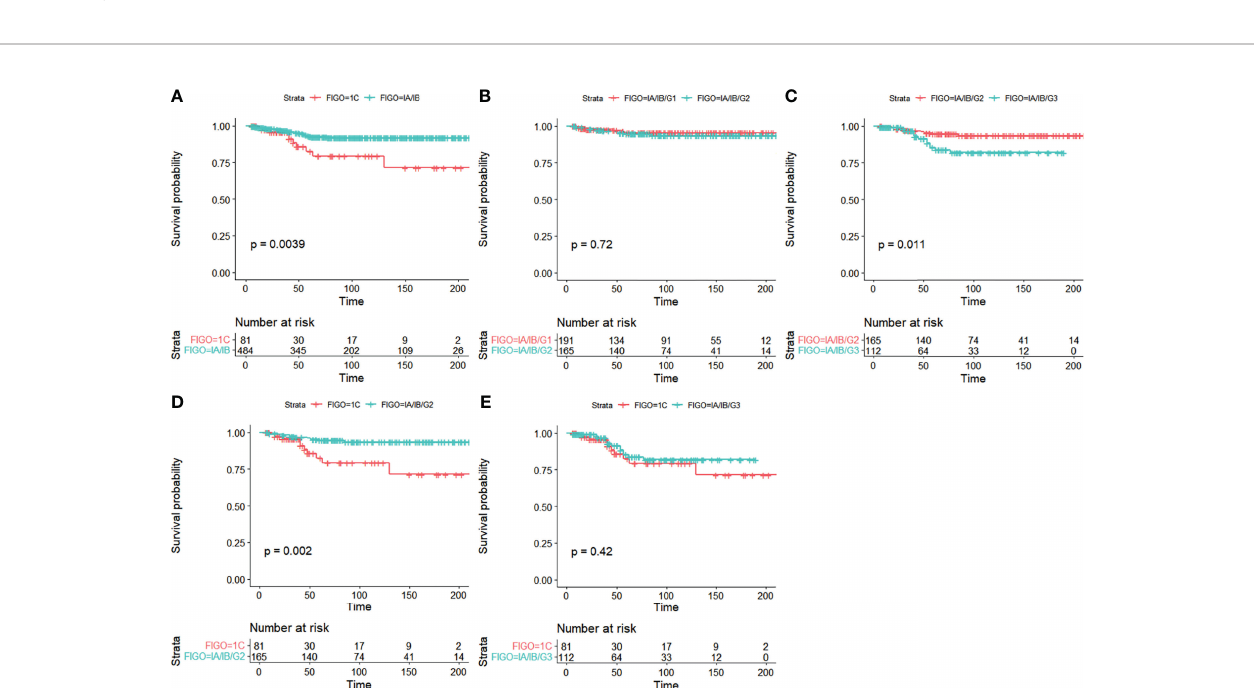
FIGURE 2 | Kaplan – Meier curves for CSS in stage I EOC. (A) Stage IA/IB vs. stage IC, (B) stage IA/IB-grade 1 vs. stage IA/IB-grade 2, (C) stage IA/IB-grade 2 vs. stage IA/IB-grade 3, (D) stage IA/IB-grade 2 vs. stage IC, and (E) stage IA/IB-grade 3 vs. stage IC.